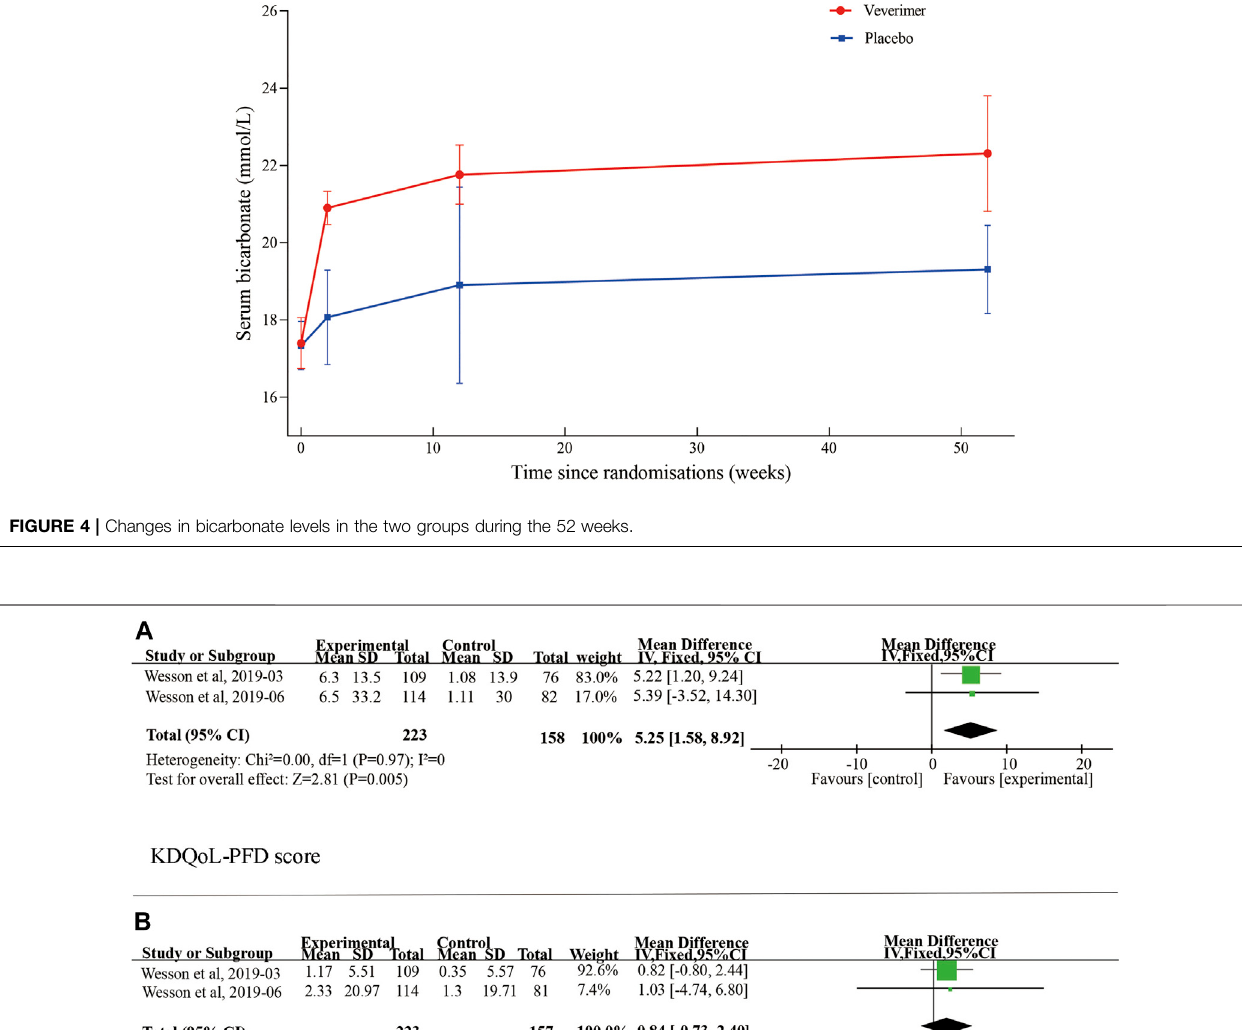
Frontiers in Pharmacology |